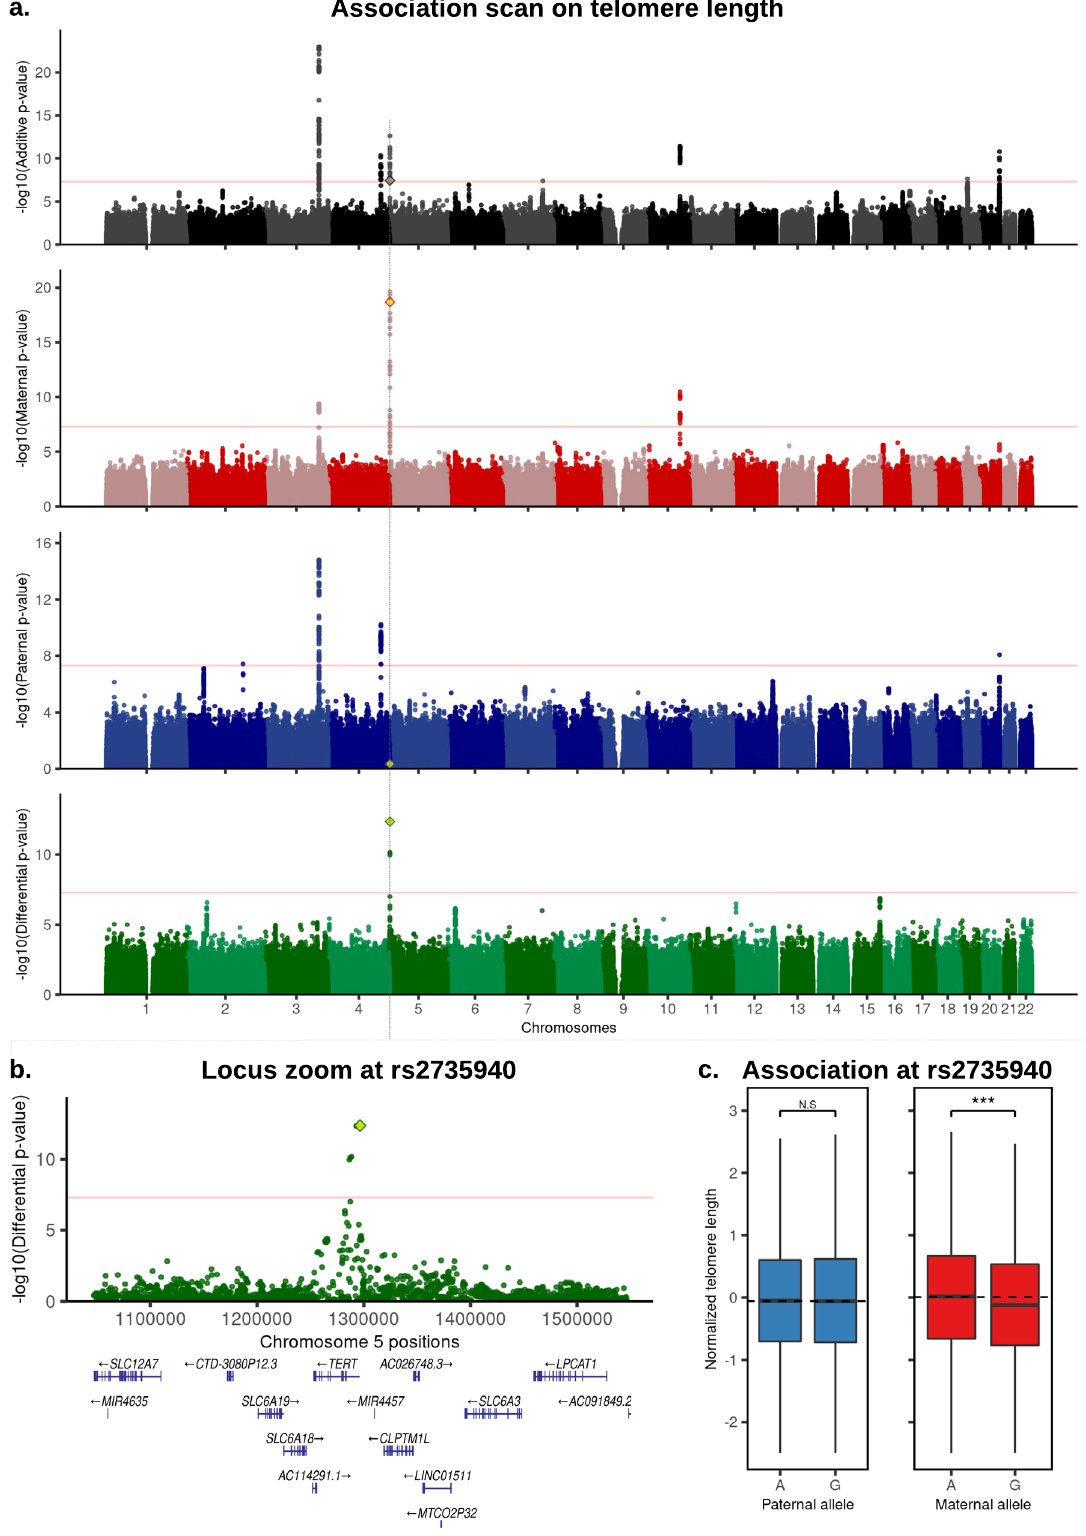
Fig.4|AssociationscansforPofOeffectsontelomerelength.a Manhattanplots offourassociationscanswithtelomerelength.Fromtoptobottomplotsareshown results for additive (black), maternal (red), paternal (blue) and differential (green) models. The lead variant mentioned in this study (rs2735940) is shown with a diamond. Red horizontal lines indicate genome-wide signi fi cance threshold at − log10(5×10 − 08 ). b Locus zoom atrs2735940onthe differential scan. c Box plot of the normalized telomere length ( y -axis) strati fi ed by risk alleles and origin at SNP